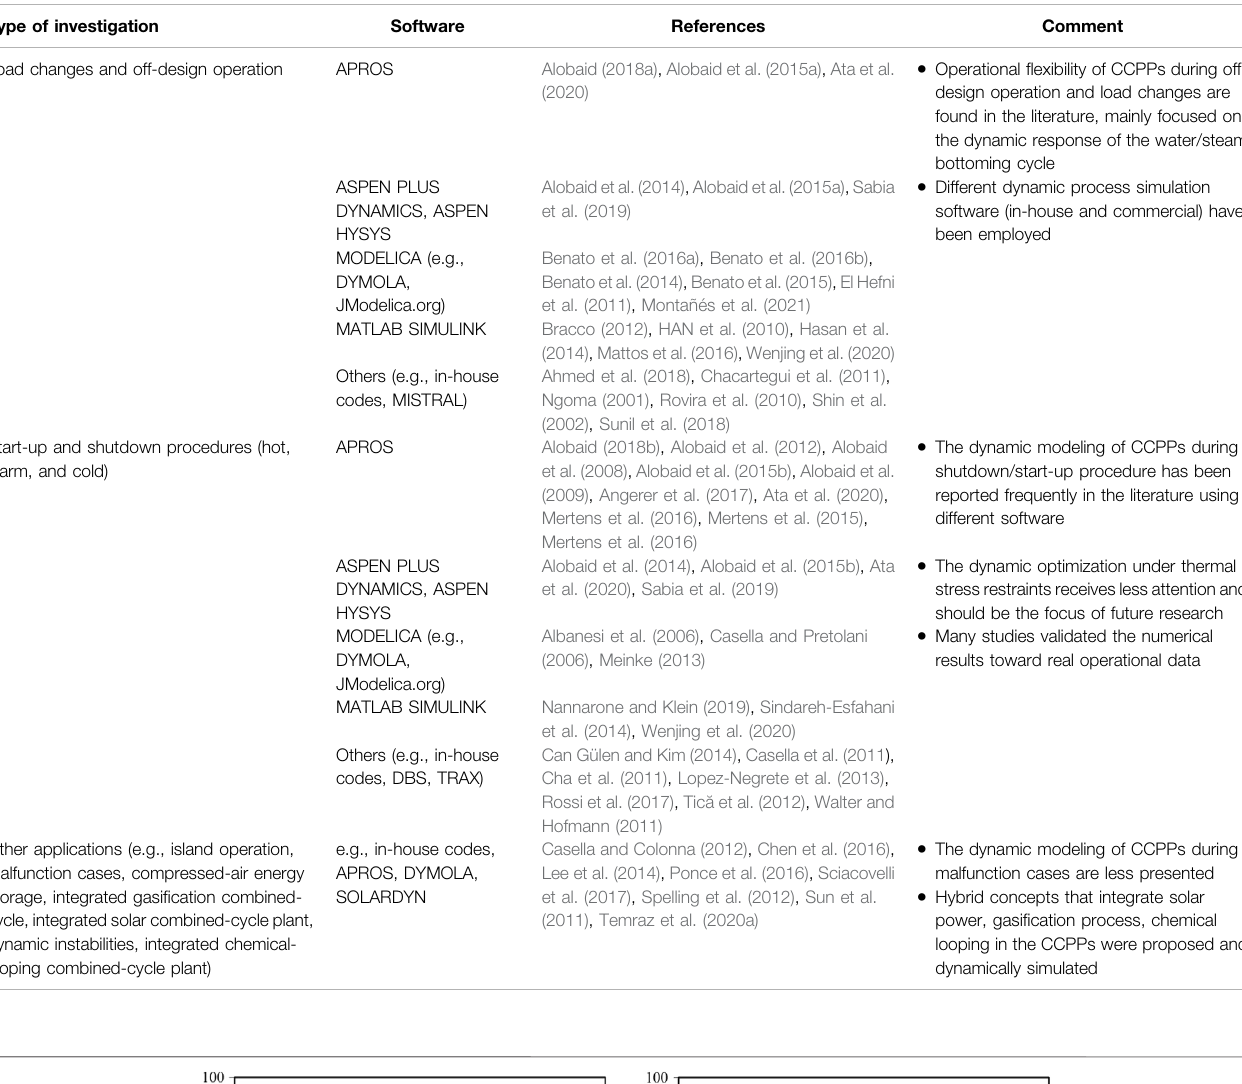
TABLE 4 | Overview of dynamic simulation studies applied to combined-cycle power plants.